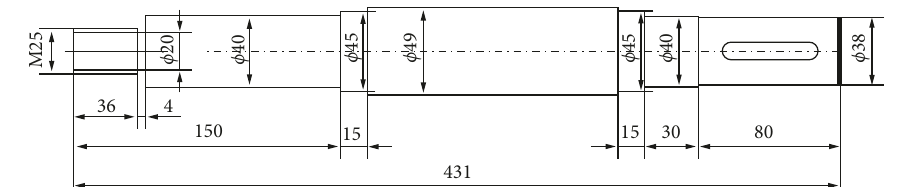
Figure 21: Dimension drawing of the pump shaft.